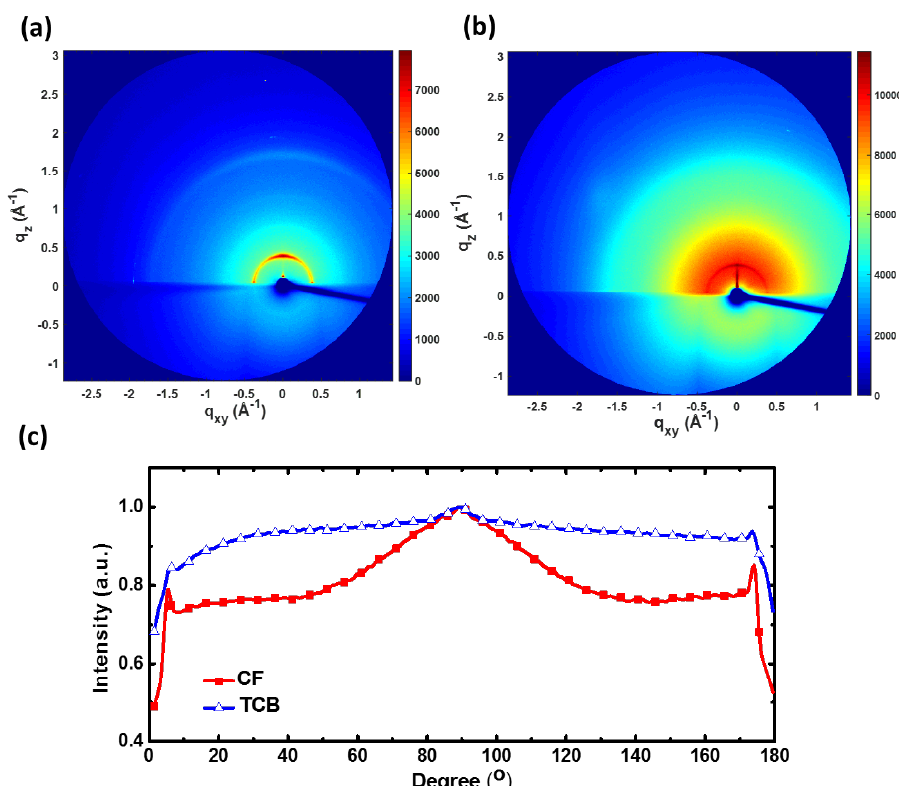
Figure 9. Two-dimensional grazing incidence X-ray diffraction (2D-GIXRD) patterns of P3HT electrospun nanofibers prepared from ( a ) CF and ( b ) TCB systems. ( c ) Azimuthal angle analysis of (100) lamellar packing for CF and TCB systems.